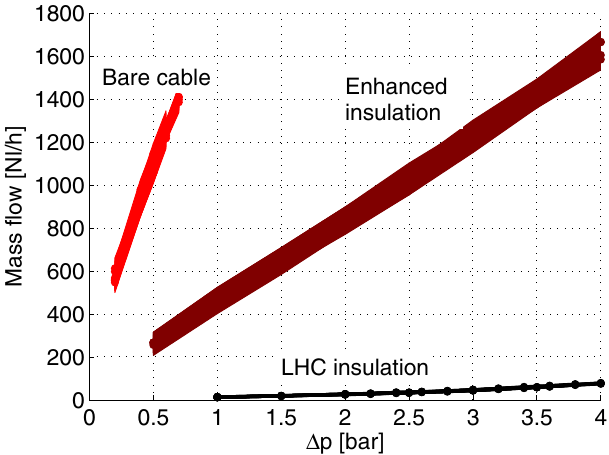
FIG. 13. (Color) Radial flow in cables with no insulation, LHC and enhanced insulations; vertical compression of 10 MPa.